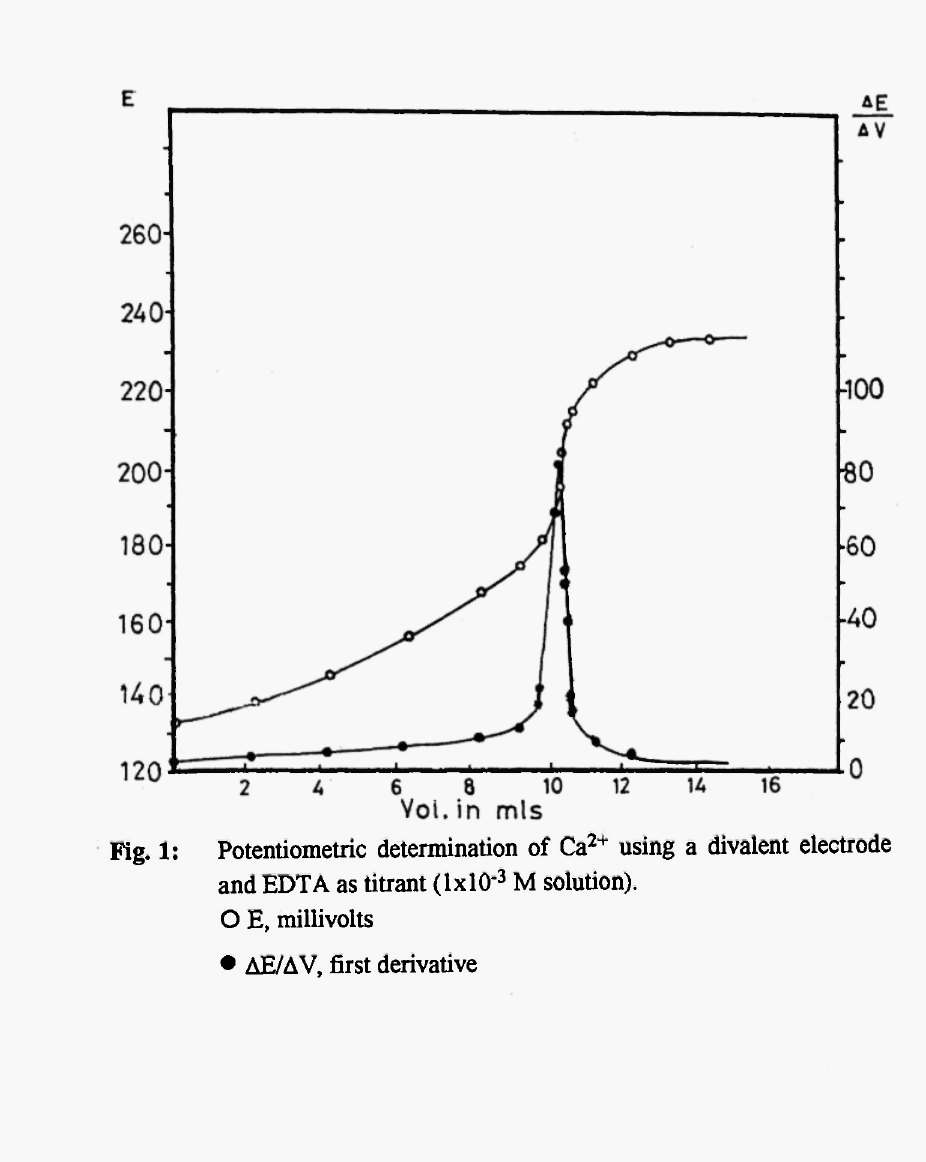
Fig. 1: Potentiometrie determination of Ca 2+ using a divalent electrode and EDTA as titrant (lxlO' 3 Μ solution). Ο Ε,